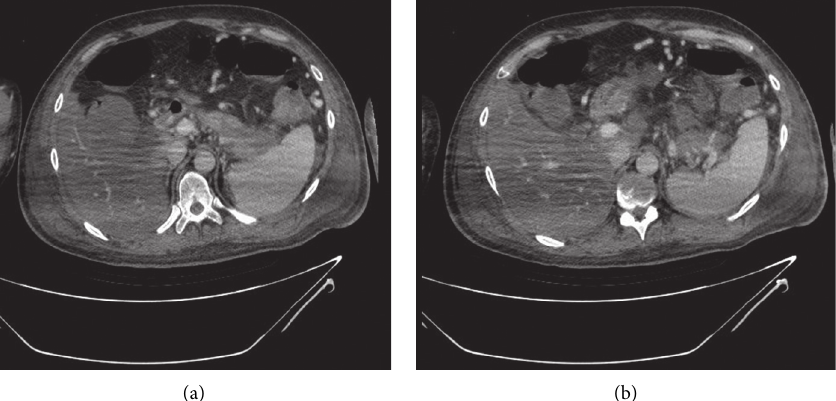
Figure 3: Heterogeneity and edema of the pancreatic tail with low enhancement (a) and splenic vein thrombosis with multiple collaterals